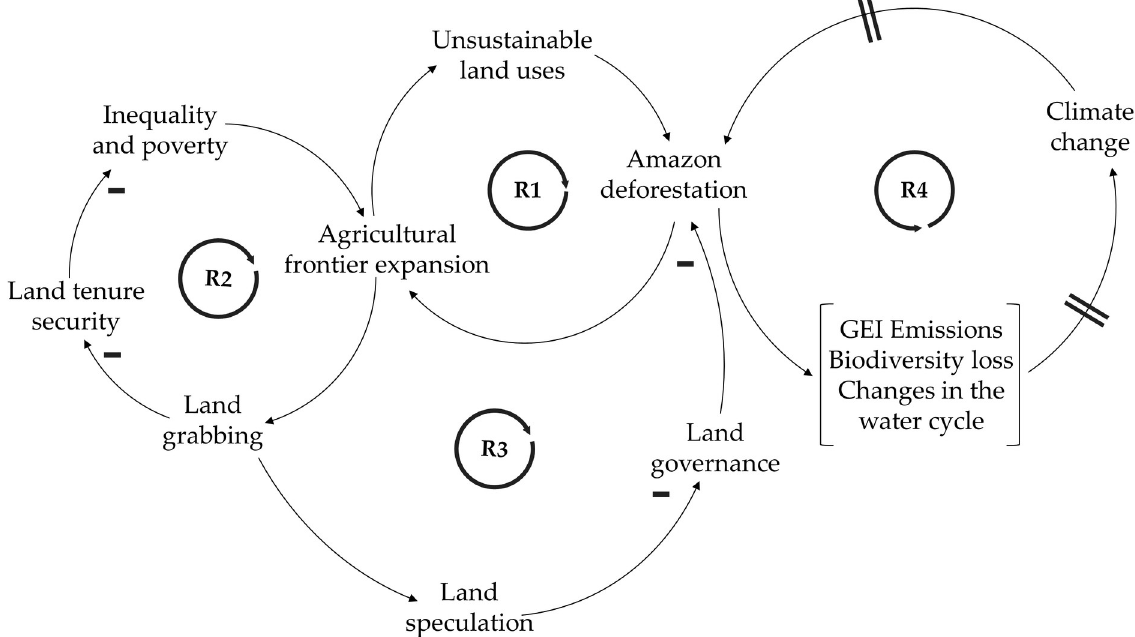
Fig 3. Causal loop diagram of land use conflicts in Caqueta´, Colombia. Key elements are joined by arrows indicating where there is a causal relationship between them. A (-) sign adjacent to an arrow indicates that the cause has a negative effect; if the cause has a positive effect there is no sign. The encircled R in each loop center means that the loop is a reinforcing loop (positive feedback). The equal sign located on the arrows symbolizes a delay in the system.